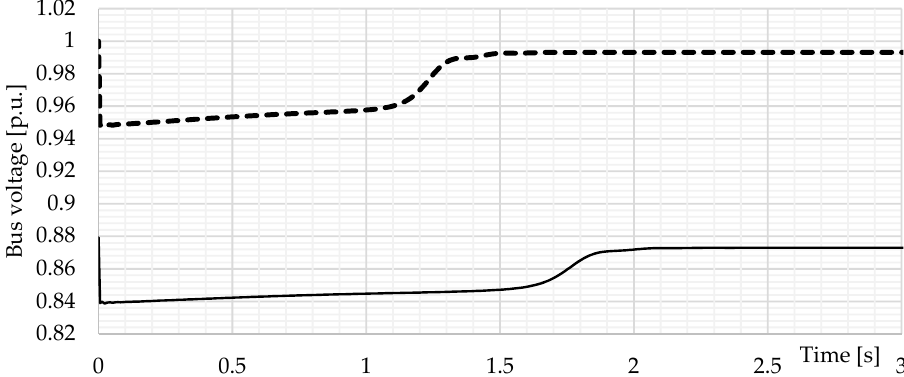
Figure 12. Voltage sag on 400 V bus during the 110 kW asynchronous motor start with SVC implemented (dashed line) and without SVC implemented (solid line).